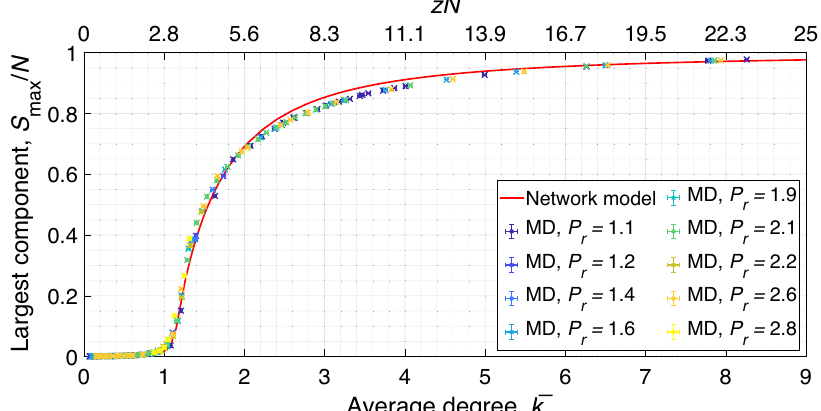
Fig.6|Relativesizeofthelargestcomponentasafunctionofaveragedegreein the system. The network model is shown in red, while MD simulation data are represented with symbols colored based on the isobar. Error bars represent one